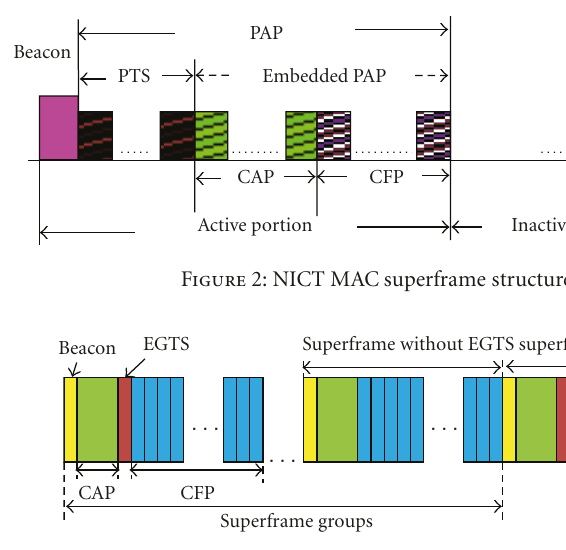
Figure 3: Superframe structure of HBC.